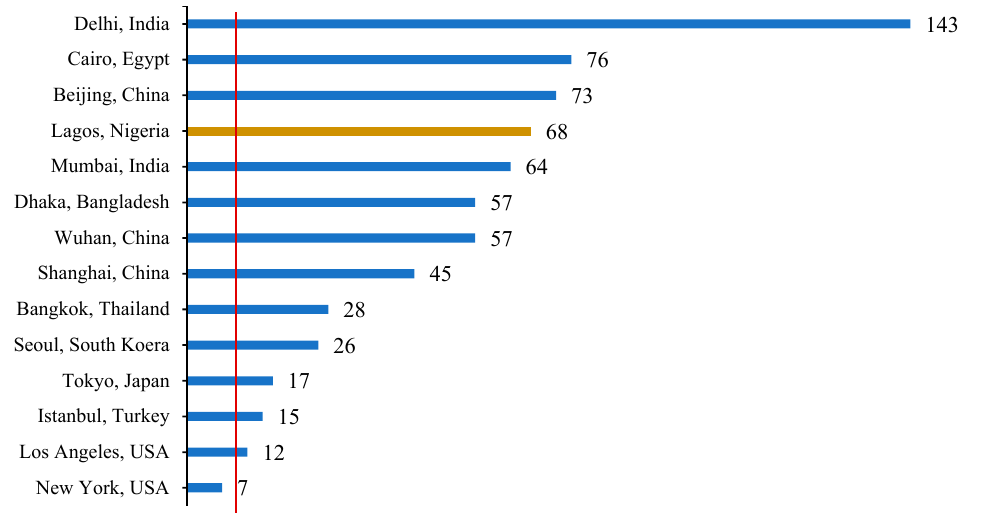
Figure 4. Annual mean concentration of PM 2.5 (µg/m 3 ) in various cities [61].